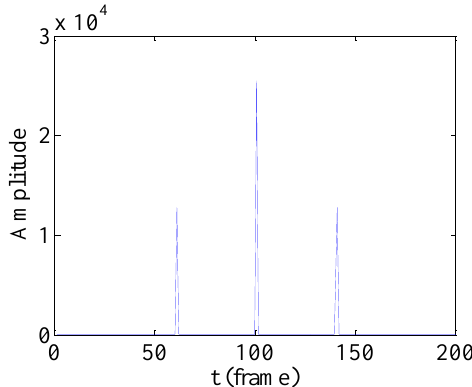
Figure 3. Spectrum distribution of each pixel along the temporal axis.